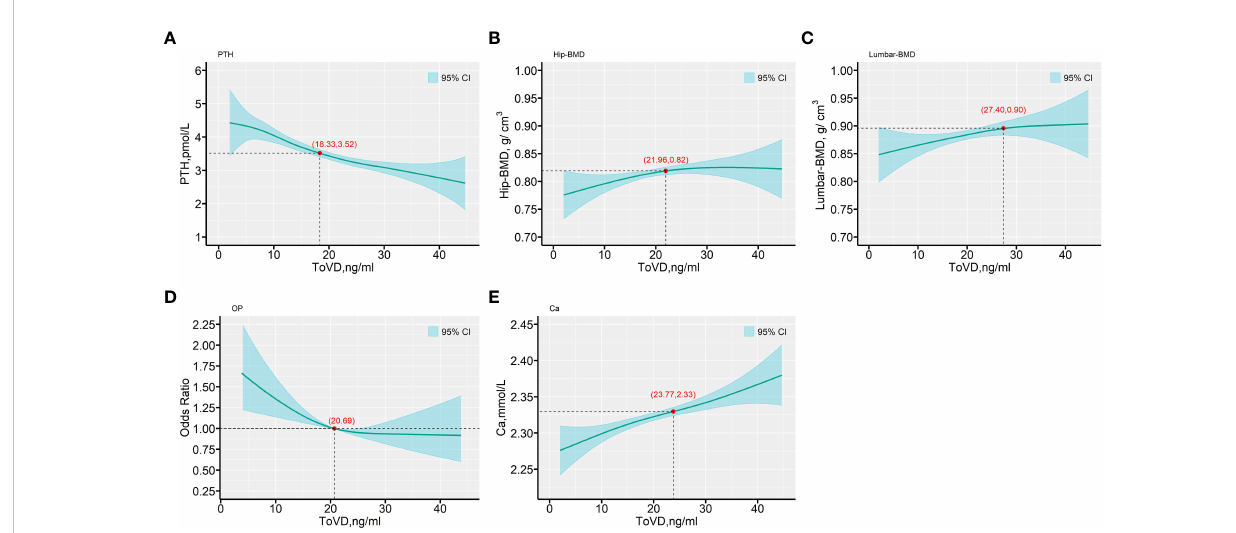
FIGURE 3 The predictive values for the outcomes of PTH, BMD biomarkers, OP risk and Ca, as functions of ToVD (ng/ml). (A) PTH; (B) Hip-BMD; (C) Lumbar- BMD; (D) OP; (E) Ca. The fi tted values are shown in cyan lines, with a reference line provided ( — ). The Bayesian 95% con fi dence intervals are included in with cyan-color areas and calculated as described in the text. All plots are from generalized varying coef fi cient models (GVCM) with penalized cubic regression splines for the smooth coef fi cient functions. The smoothing parameters were selected by the generalized cross- validation (GCV) criterion. The red points with axis values denote the tangent points with the maximum changes of the predicted values by ToVD. In all panels, multivariate analyses were adjusted for age (in years, continuous), sex (men or women), educational status, smoking status, drinking status, dietary types, family income levels, seasons, regions and MAHS (in hours, continuous). The missing data were imputed by multiple imputation and all estimations were combined across the 5 imputed datasets using the Rubin ’ s method. ToVD, total 25(OH)D; PTH, parathyroid hormone; Hip-BMD,